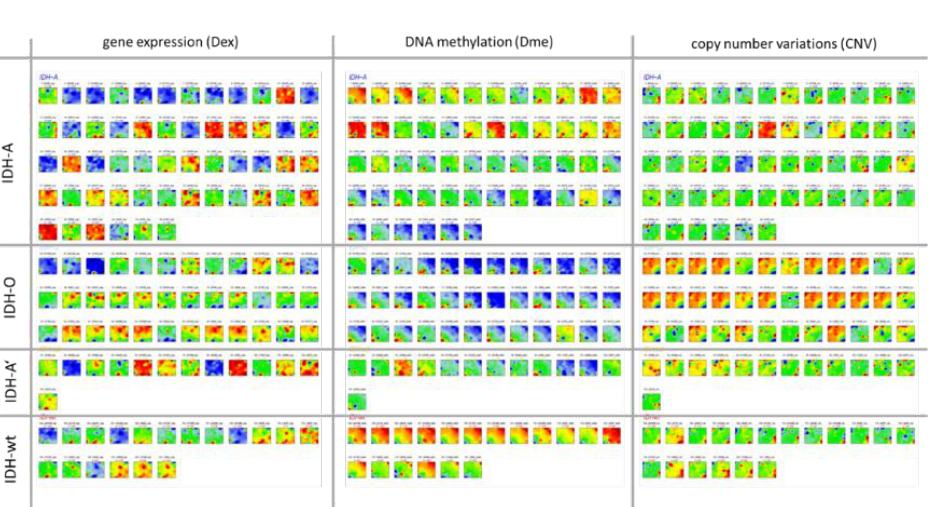
Figure A1. Gallery of single (personalized) tumour portraits in the different omics domains. Mean group portraits are shown in Figure 4a.